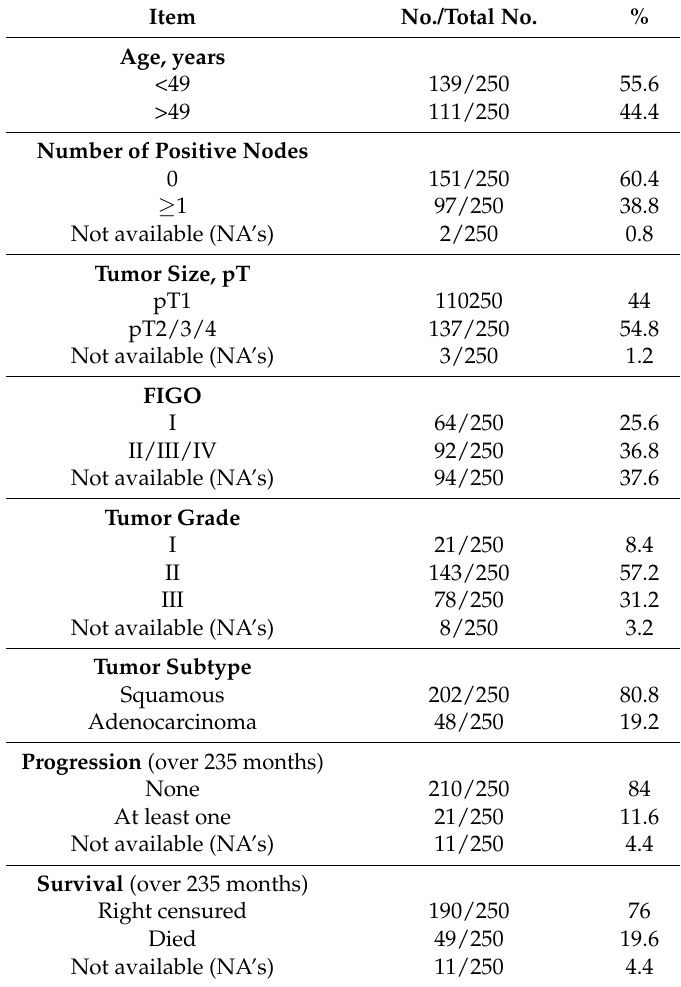
Table 1. Clinic pathological variables of the patients included in this